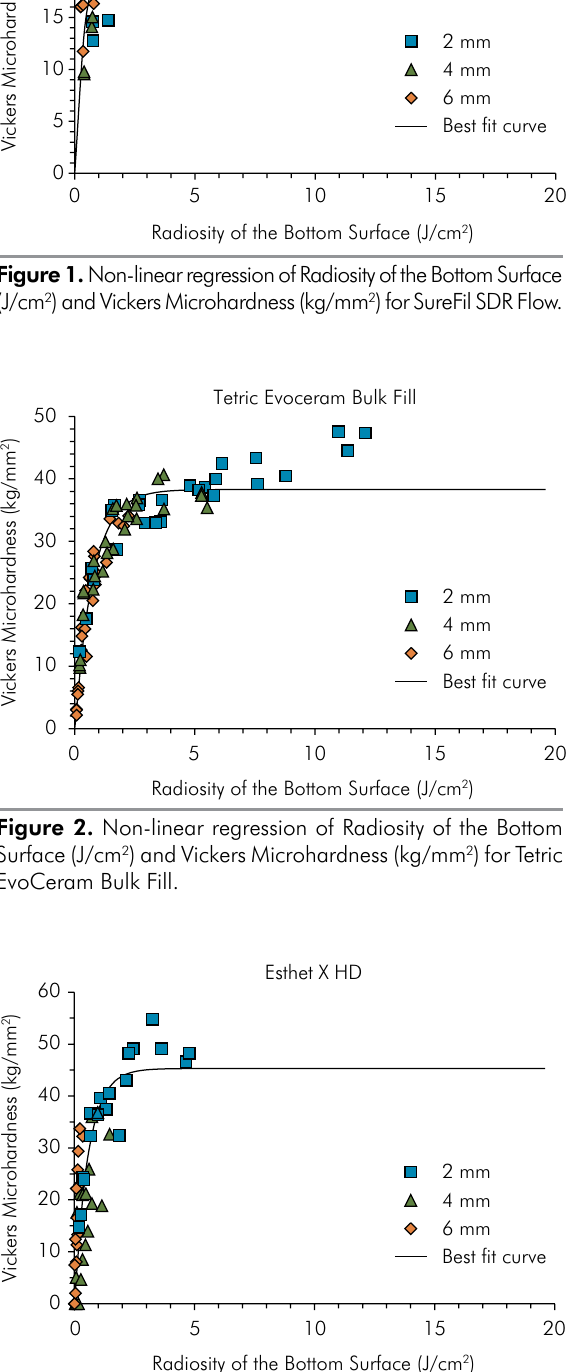
Figure 3. Non-linear regression of Radiosity of the Bottom Surface (J/cm 2 ) and Vickers Microhardness (kg/mm2) for Esthet X HD.